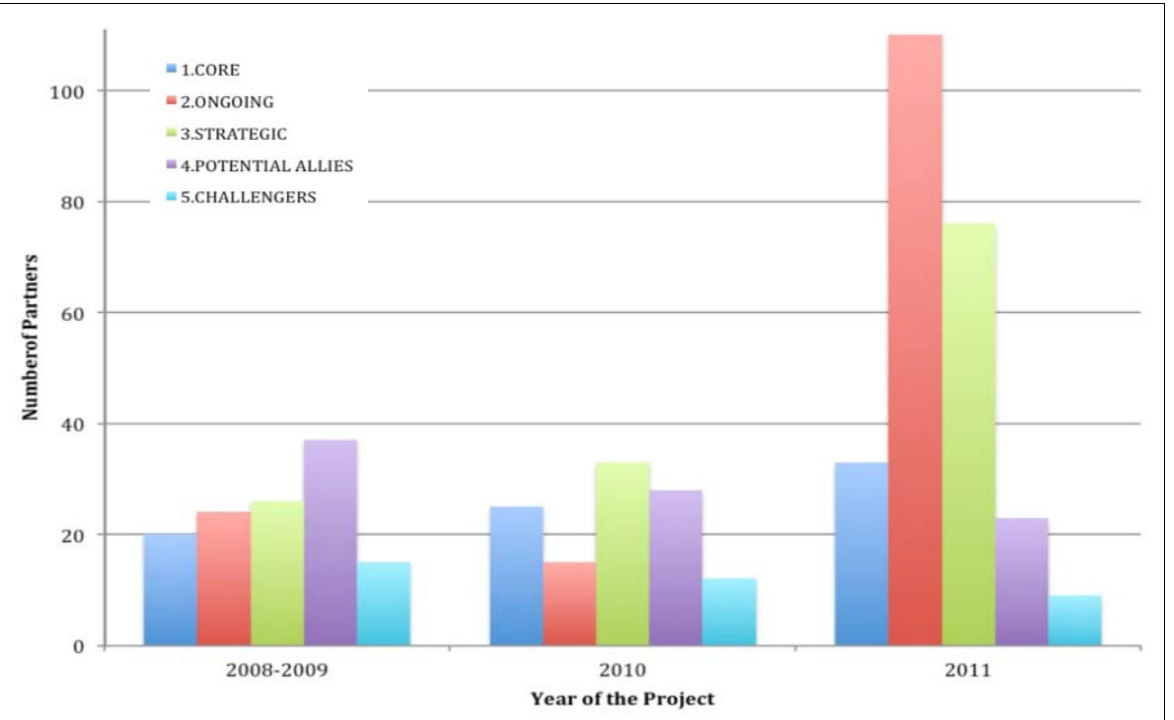
Figure 4. Number and Type of HFFPC Partners, 2008 to